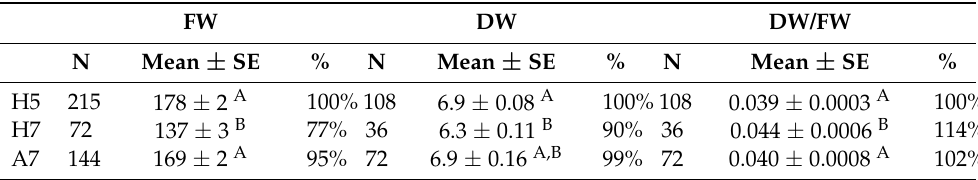
Table 6. Shoot mean, standard error (SE), and percentage comparison to H5 response for fresh weight (FW, g), dry weight (DW, g), and dry weight to fresh weight ratio (DW/FW, g/g) by trial and treatment with multi-model significance. Differing letters within response variables (columns) denote significance at alpha = 0.05. FW DW DW/FW